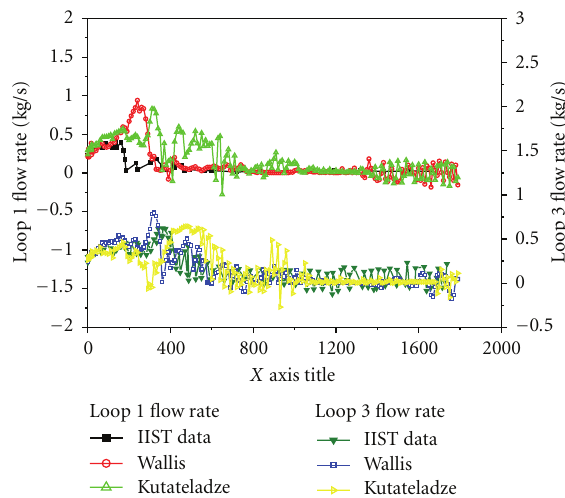
Figure 5: The comparison of loop 1 and loop 3 flow rate among Wallis form, Kutateladze form, and IIST